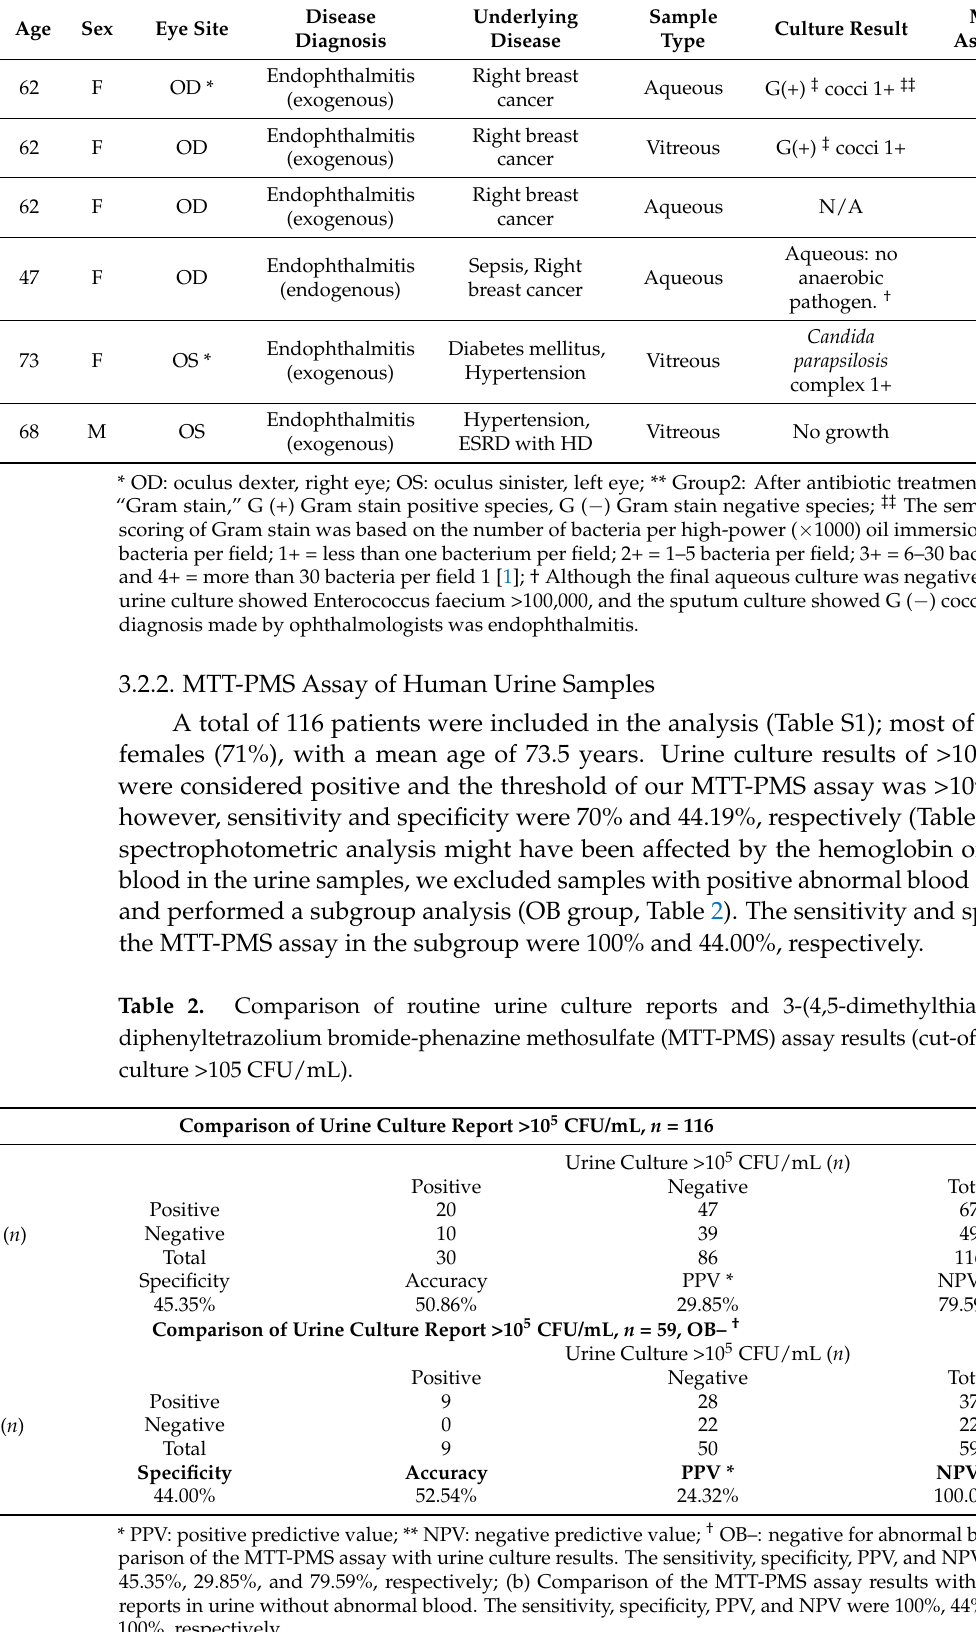
Table 1. Characteristics of patients with endophthalmitis and their test results.